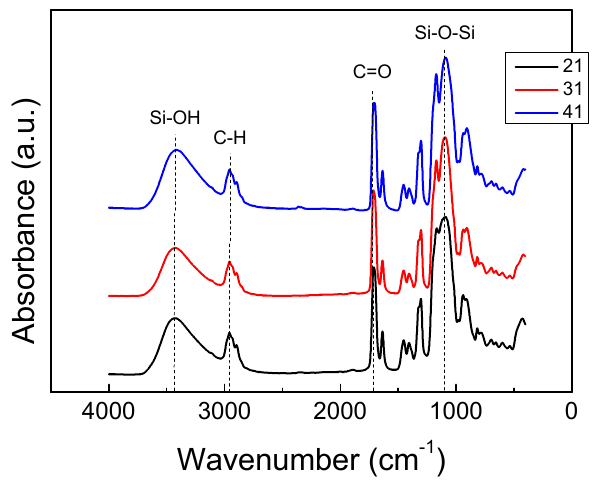
Figure 3 . FTIR spectra obtained for γ -methacryloxypropyltrimethoxysilane (MAPTMS)/ tetramethylorthosilicate (TMOS) mixtures in the EtOH/H 2 O solvent system for 21, 31 and 41 samples after 12 h of hydrolysis.